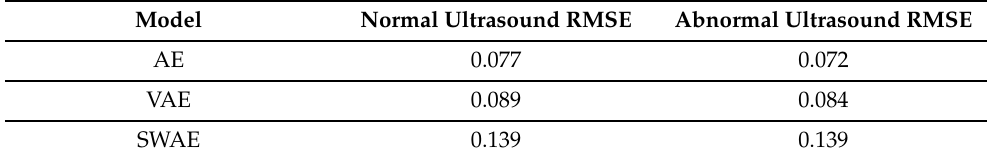
Figure 9. Reconstructed images by model. Table 4. Reconstruction performances of